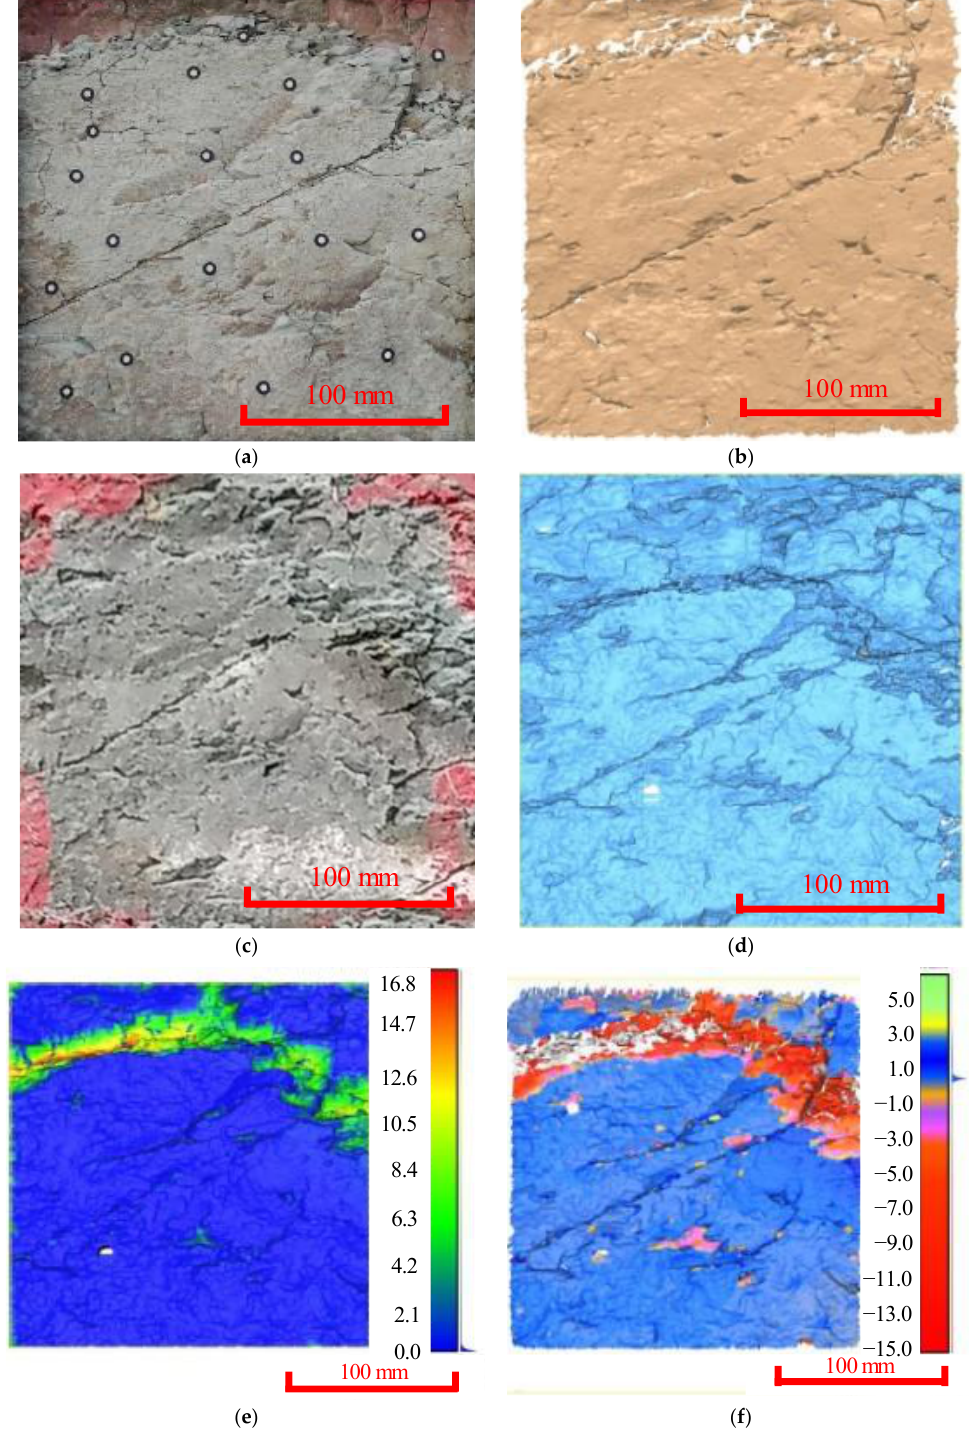
Figure 4. In situ and 3D cloud diagram of oblique joints and peeling-off blocks. ( a ) Site picture of the measuring area (Period I). ( b ) Image of the 3D laser scanning (Period I). ( c ) Site picture of the measuring area (Period II). ( d ) Image of the 3D laser scanning (Period II). ( e ) Deformation distribution obtained using the C2C method. ( f ) Deformation distribution obtained using the M3C2 method.